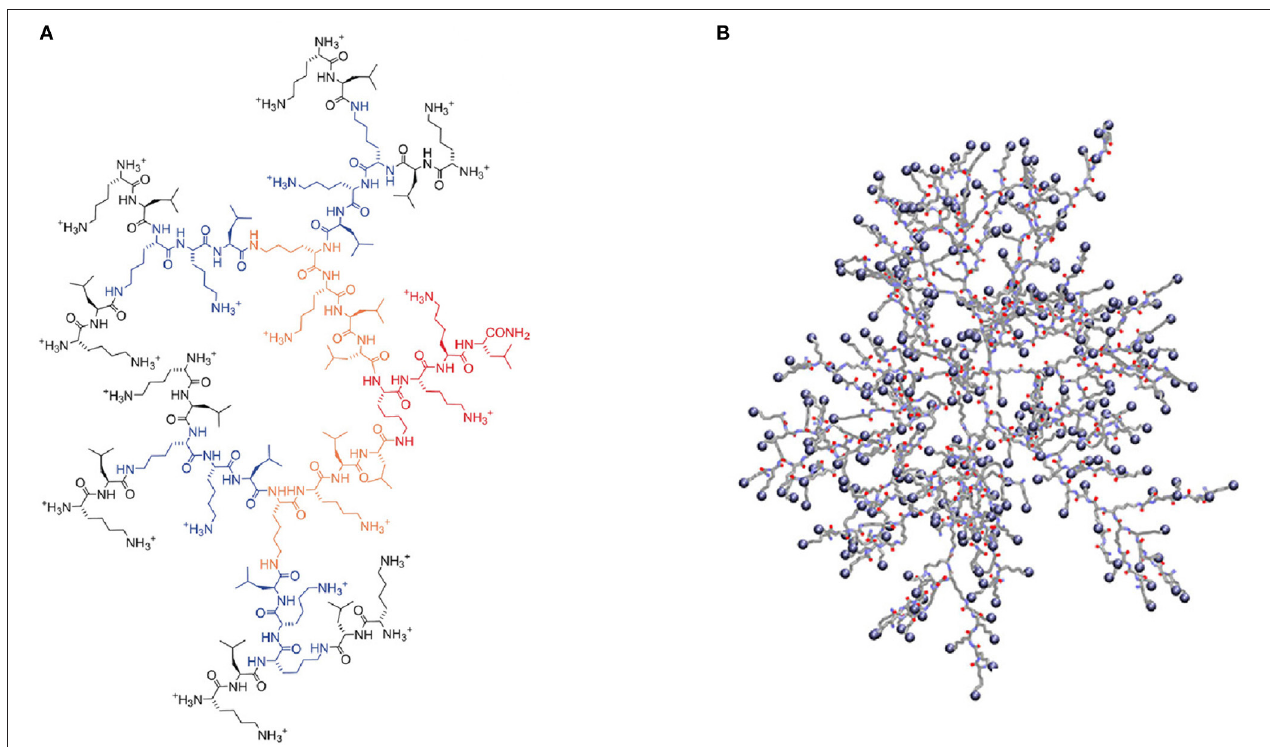
FIGURE 4 | (A) Chemical structure of G3KL (Siriwardena et al., 2018a); (B) Snapshot of G4 polylysine dendrimer in molecular dynamic simulation (Francoia et al., 2017